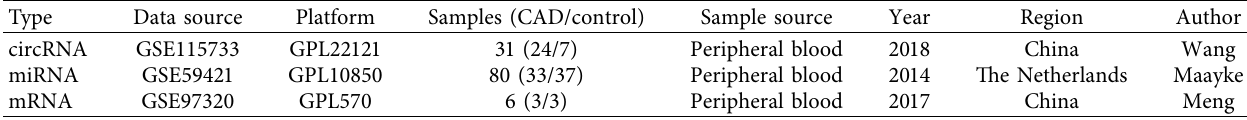
Table 1: Basic information of the microarray datasets from